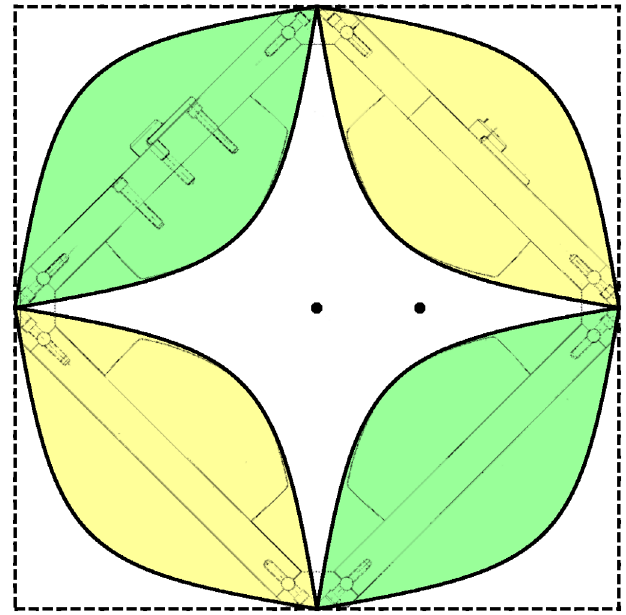
FIG. 5. Cross section at z ¼ 0 of the theoretical ideal sech 2 quadrupole (yellow and green) compared with drawing of the TRIUMF 12Q12 superposed. The yellow and green poles are circular in the orthogonal cross section, and hence shaped very much like the American football. The outer dashed square is at ‘‘ground’’ potential. Of the 12Q12 quadrupole, only the poles and theyoke are shown; coils are omitted. The black dot right of center is the location of the Hall probe for measurements of Fig. 3.